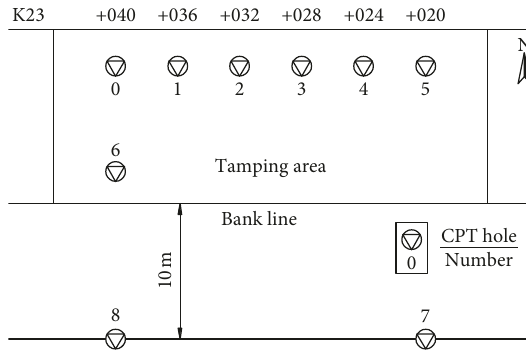
Figure 13: Layout of CPT holes after dynamic